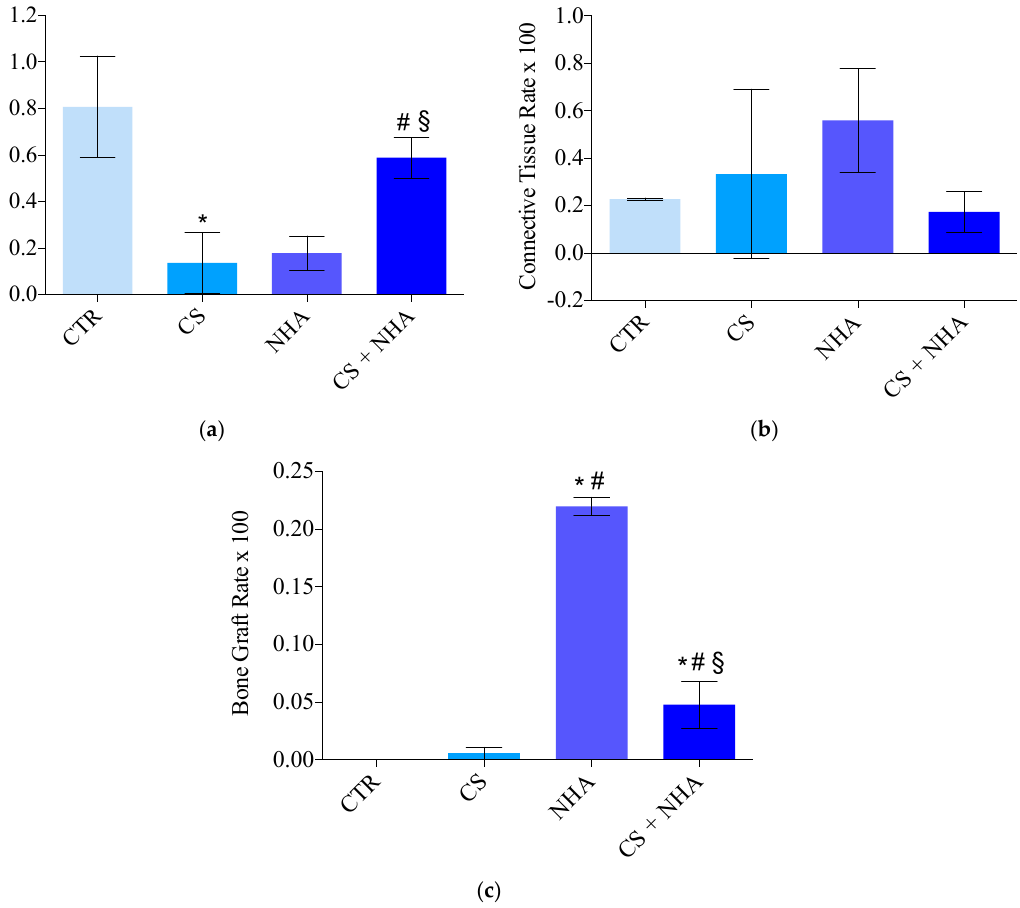
Figure 9. Histomorphometric measurements expressed in percentage: bone area rate ( a ), connective tissue rate ( b ), bone graft rate ( c ). CTR: Control; CS: Calcium sulphate; NHA: Sintered nanohydroxyapatite; CS + NHA: Calcium sulphate plus sintered nanohydroxyapatite; *: Significantly different compared to the control group; #: Significantly different compared to the calcium sulphate group; §: Significantly different compared to the NHA group.